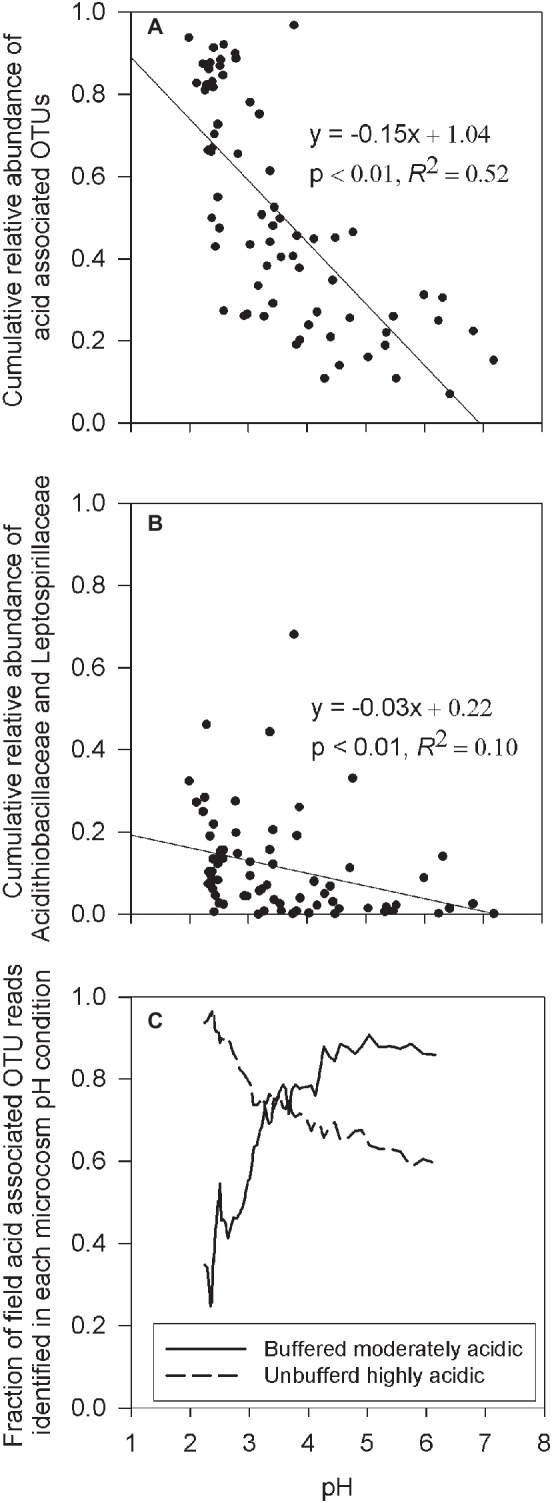
(A) Linear regression between the cumulative relative abundance of all acid-associated OTUs (Supplementary Table S1), and the pH of the field sample. (B) Linear regression between the cumulative relative abundance of all OTUs classified within the families Leptospirillaceae or Acidithiobacillaceae and the pH in the field sample. (C) Rolling nine sample average of ranked pH data denoting the rolling average fraction of acid-associated OTU reads, in field samples that were identified as OTUs present in either the buffered moderately acidic or unbuffered highly acidic systems, as a function of the field sample pH.